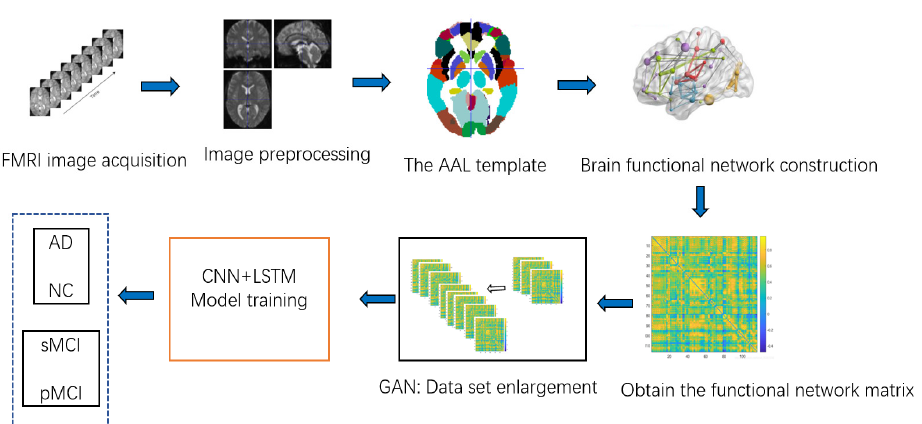
Figure 10. The overall framework for AD diagnosis and MCI prediction. The overall program flow chart of this model is shown in Figure 11.